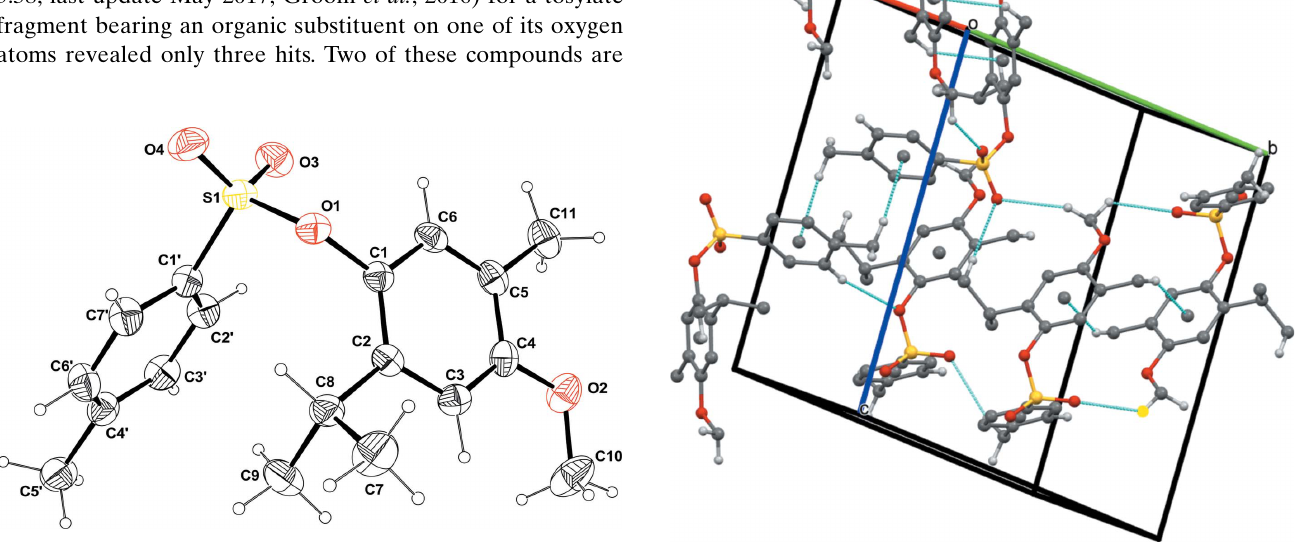
Figure 1 Molecular view of compound 2 with the atom-labelling scheme. Displacement ellipsoids are drawn at the 50% probability